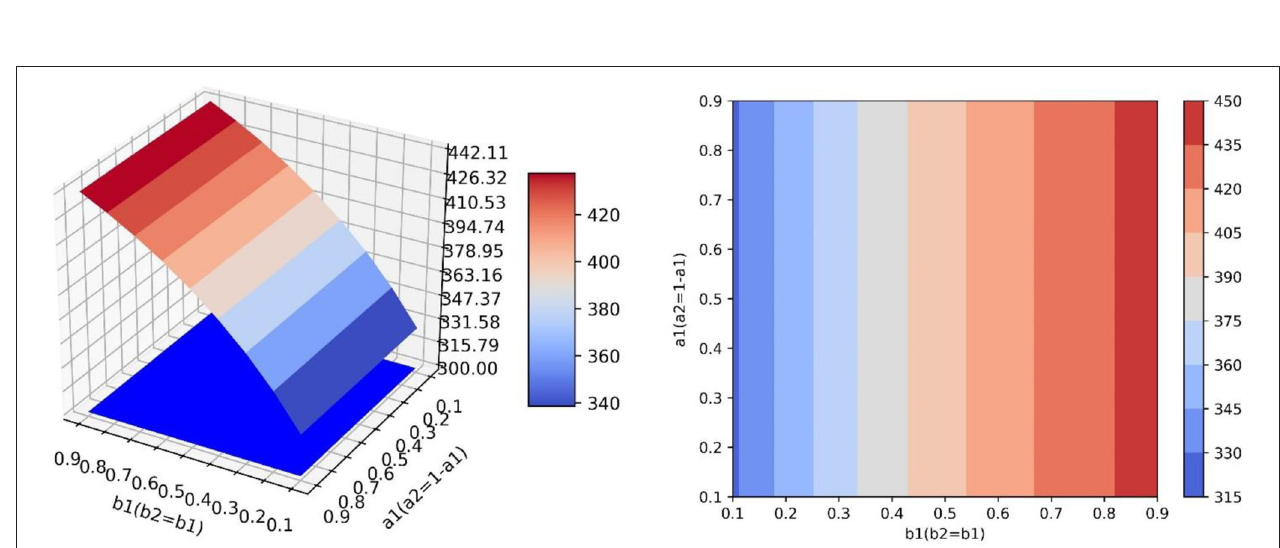
FIGURE 9 | In the scene of simulation 3, the value of positive emotion at the equilibrium point: surface graph and surface projection.